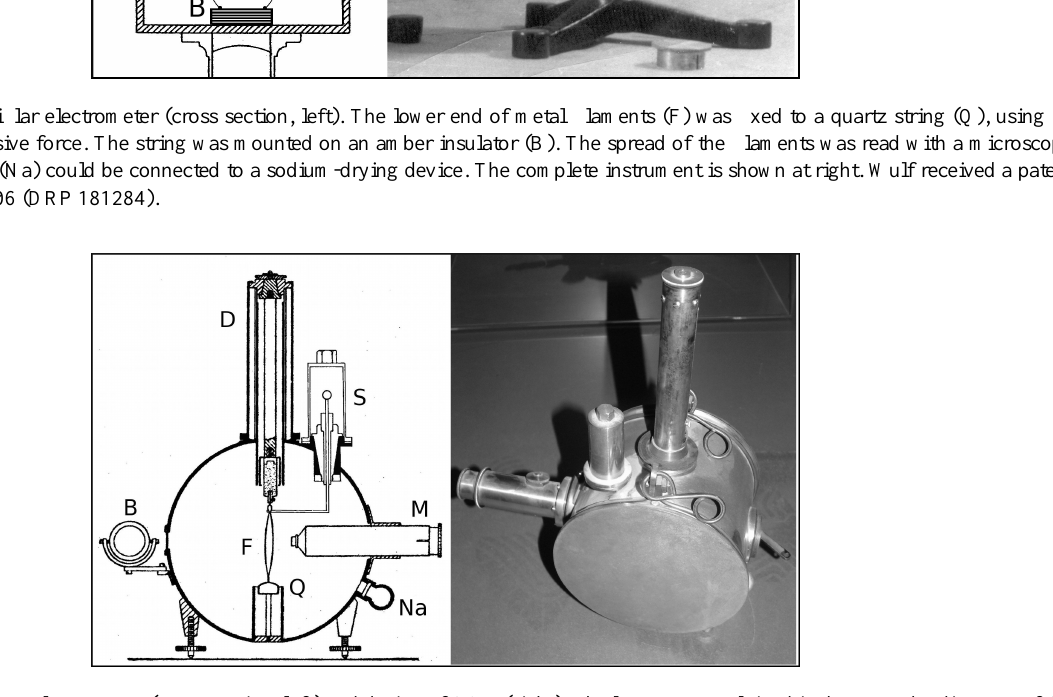
Figure 3. Wulf’s γ -ray electrometer (cross section, left) and design of G&T (right). The letters are explained in the text. The diameter of the metal case was 17cm, its width 13cm. It was this instrument that Hess used on his successful balloon flights. It is displayed in the Deutsches Museum